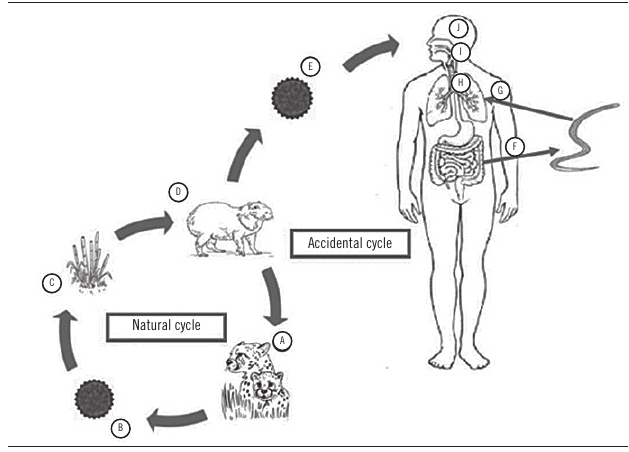
figurE 3 − Possible biological cycle of Lagochilascaris minor (A) the infected definitive host (feline) releases worm’s eggs (B) which contaminate the soil (C). The intermediate host (D) feeds on contaminated plants and becomes infected. The human enters as an accidental host by ingesting bush meat contaminated with the embryonated eggs of the parasite (E). The passage of the worm through the digestive tract (F) leads to its evolution, followed by a possible pulmonary cycle (G), in which Lagochilascaris ascends through the respiratory tract, migrating toward neighboring regions (H), such as lymph nodes (I) and the central nervous system (J).